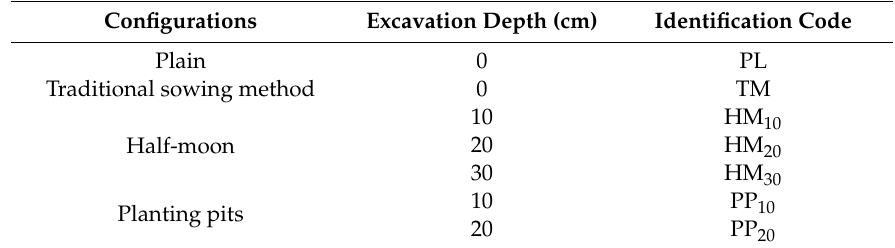
Table 1. Characteristic and identification codes for the di ff erent rainwater harvesting techniques (RWHT) configurations